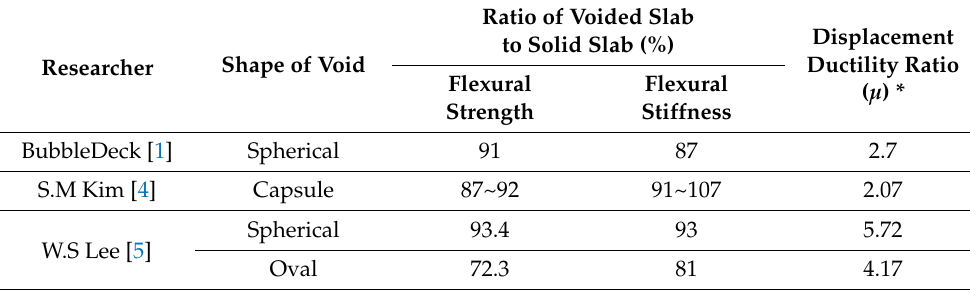
Table 1. Flexural capacities of the current voided slab system.